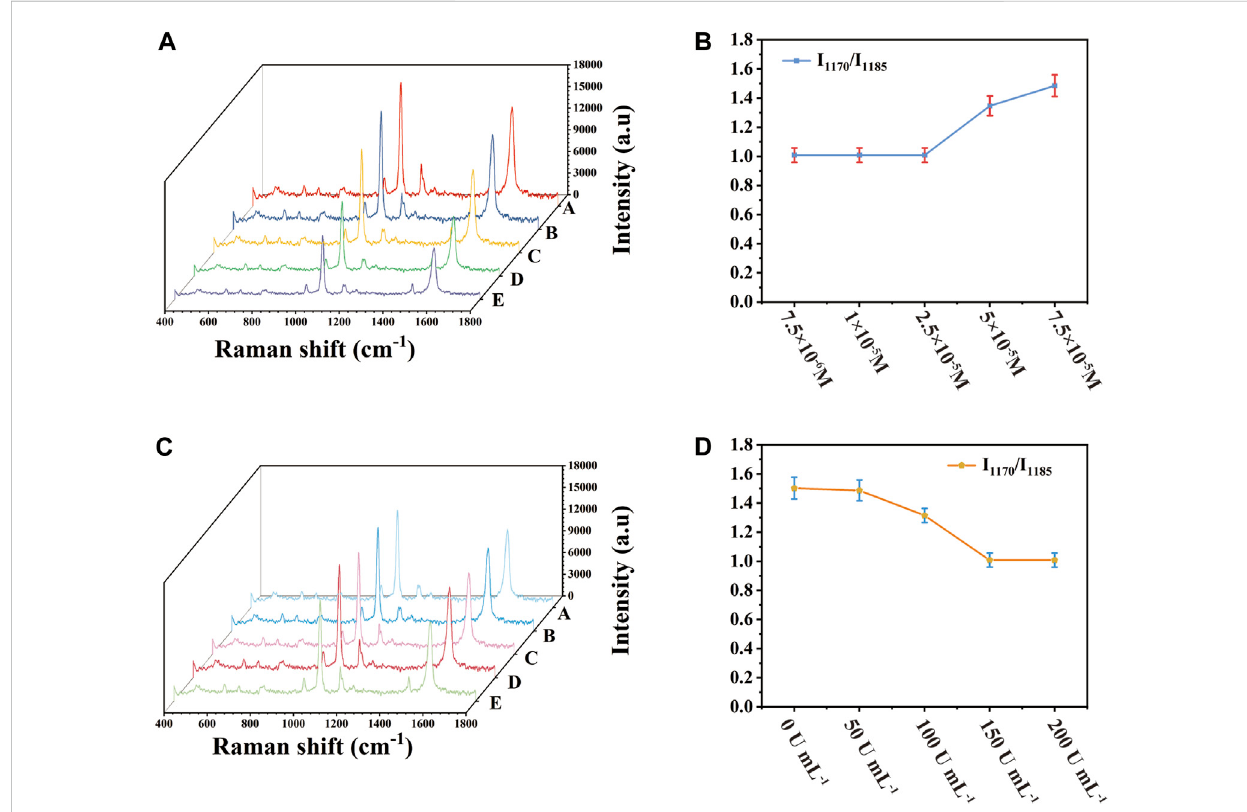
FIGURE 3 Relationship between 4-ATP concentration and SOD concentration and I 1170 /I 1185 (A) SERS spectrum when 4-ATP concentration was changed, (B) corresponding scatter plot, (C) SERS spectrum when SOD concentration was changed, (D) corresponding scatter